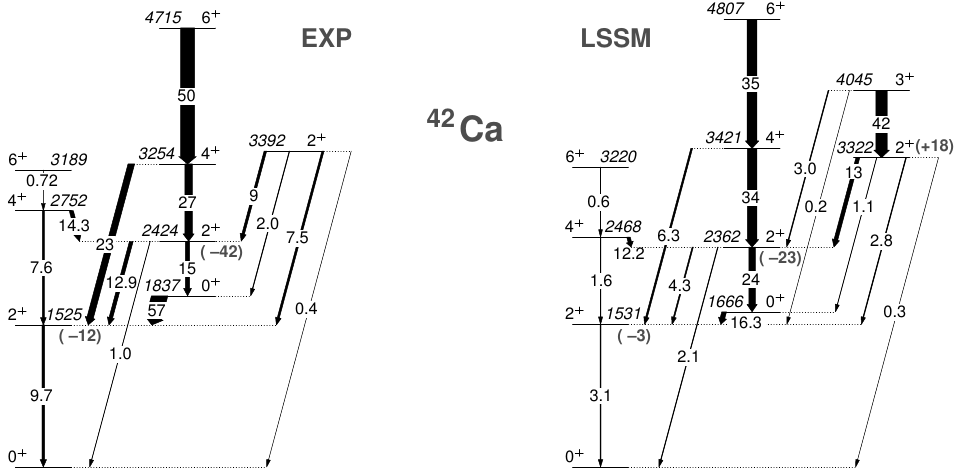
Figure 2. Comparison of the experimental low-energy part of the 42 Ca level scheme with that calculated using Large-Scale Shell Model (LSSM) [3,18]. States are labelled with their energies in keV, transitions with E 2 transition probabilities in Weisskopf units and spectroscopic quadrupole moments for the 2 + states, expressed in e fm 2 , are reported in